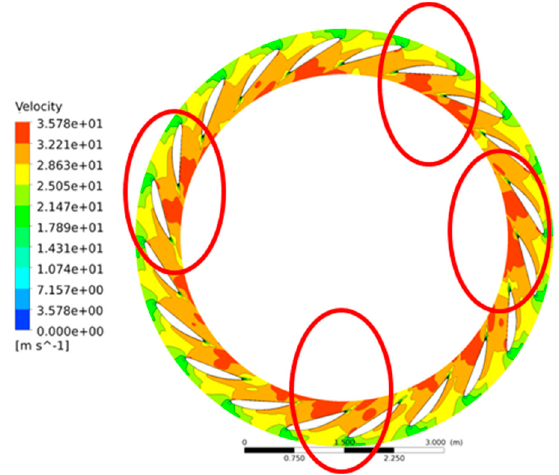
Figure 10. Velocity contour in the vaneless space with 7 runner blades.